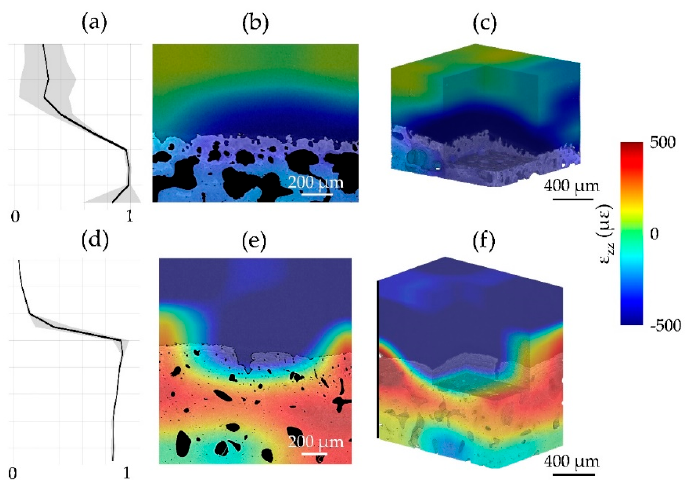
Figure 5. Correlation coe ffi cient and full-field axial strain ( ε zz ) representation in zero-strain test for ( a – c ) CB1 and ( d – f ) CB5 specimens imaged at 3 × and 4 × propagation-based phase-contrast (PC), respectively. ( a , d ) The mean correlation coe ffi cient (black line) across all the slices and its standard deviation (gray shaded region) is shown along the cartilage-bone plug length. ε zz distribution for a cross-section of ( b ) CB1, ( e ) CB5 and for ( c , f ) their volumes were computed using a multipass scheme (48 voxel final sub-volume size).